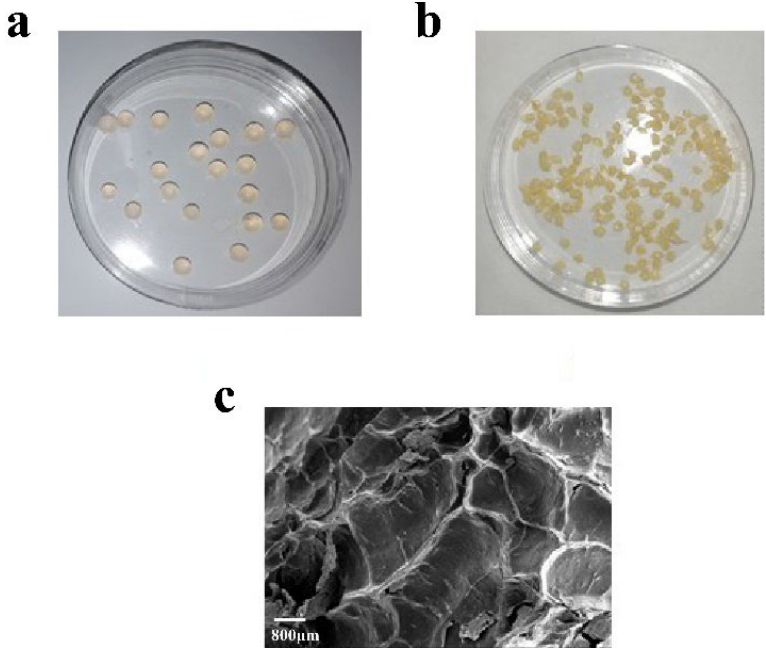
Figure 9. Effects of sodium alginate concentration ( a ), glutaraldehyde concentration ( b ), CaCl 2 concentration ( c ), fixing and cross-linking time ( d ) on κ -selenocarrageenase activity in immobilization process.